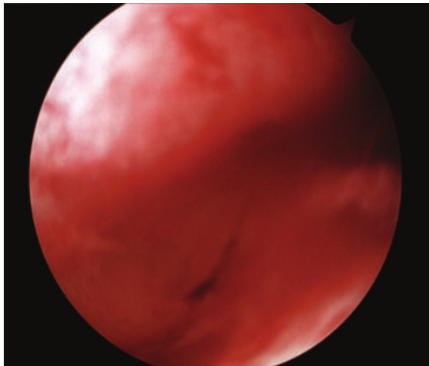
Figure 3: Vaginoscopy: stenosis of vaginal septum site, three months after the initial excision and